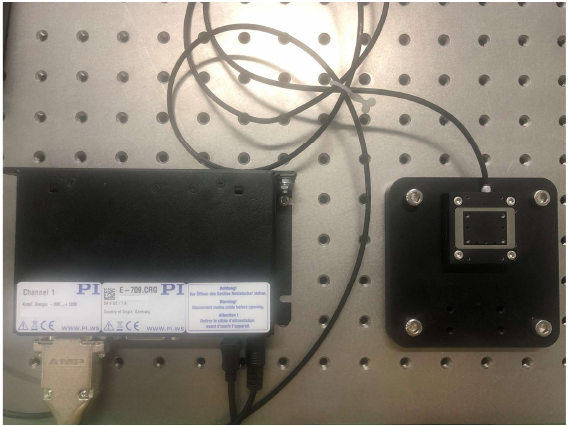
Figure 2. Experimental platform diagram.